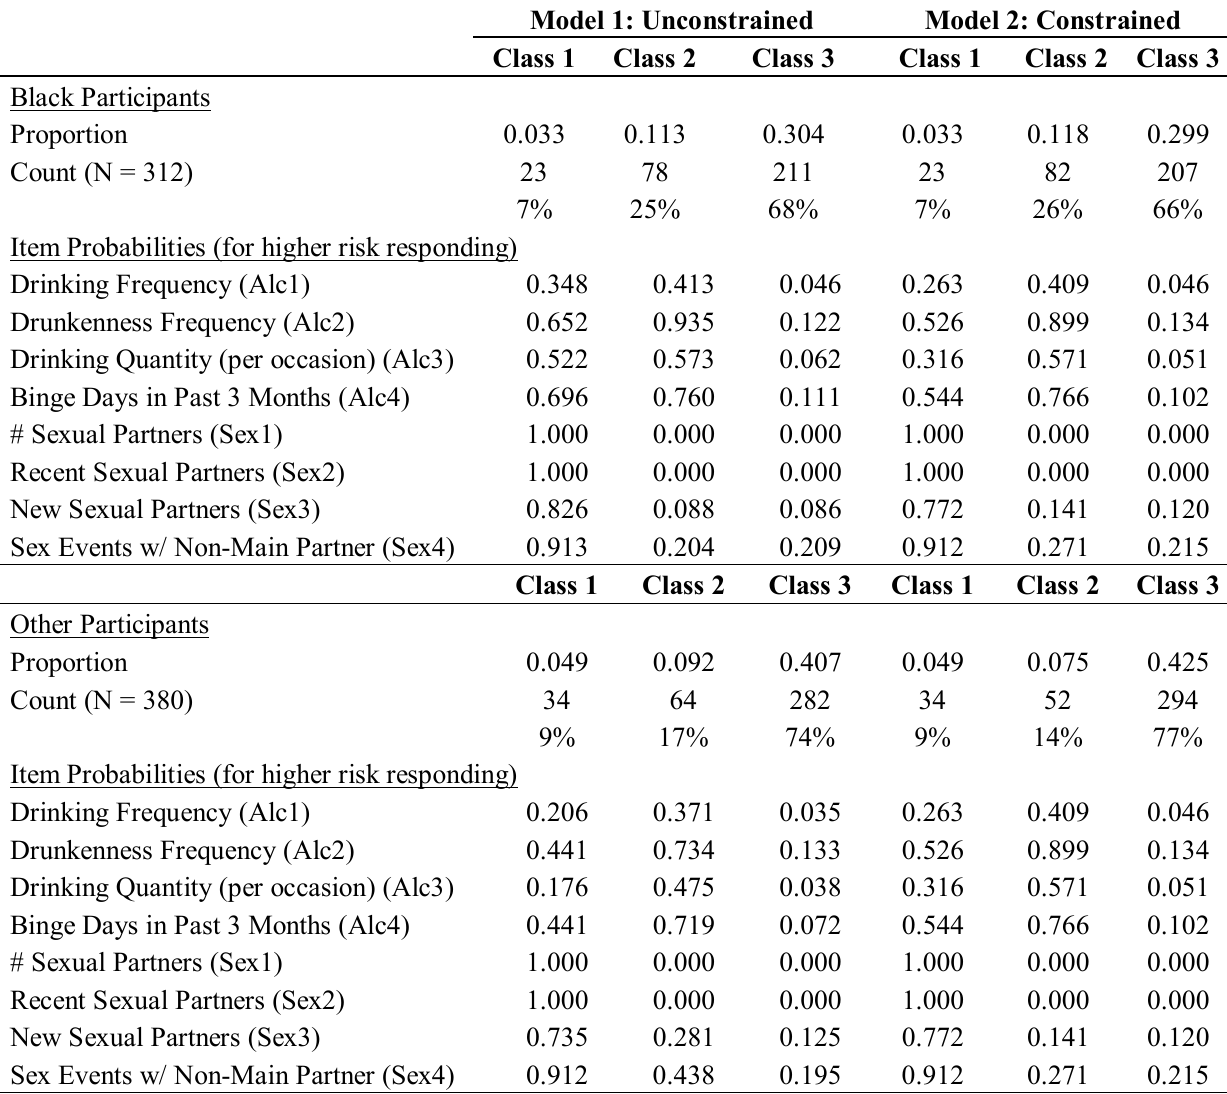
Table 2. Comparison of parameters across the unconstrained and constrained